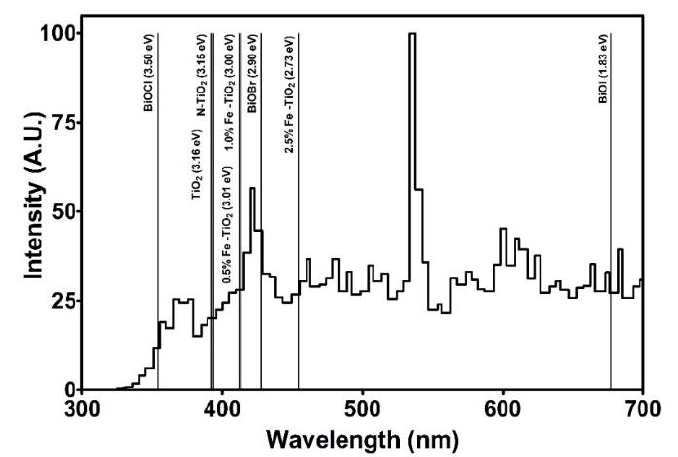
Figure 2. The emission spectrum of the Osram Powerstar HQI-E 400 W / D Pro Daylight lamp (adapted from the spectral distribution reported in the lamp’s datasheet). Vertical lines represent the bandgaps of titanium dioxide- and bismuth oxyhalide-based photocatalysts. Table 4. Product selectivity of the photocatalytic oxofunctionalization of cyclohexene over the synthesized